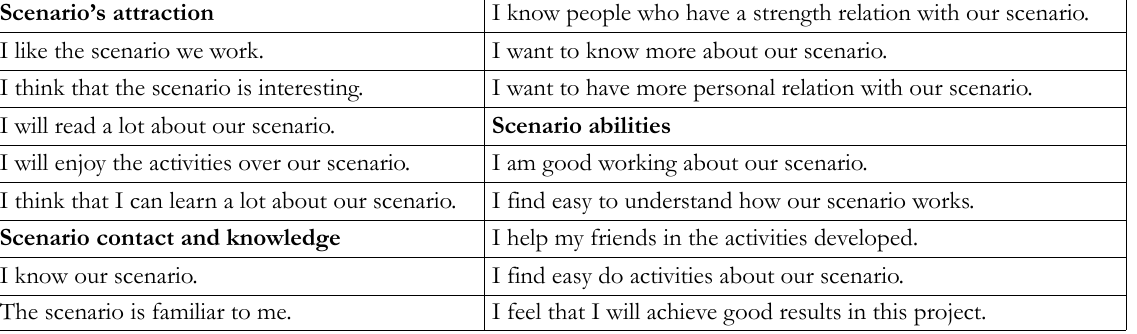
Table 4. Pre-test and post-test questions for students regarding the